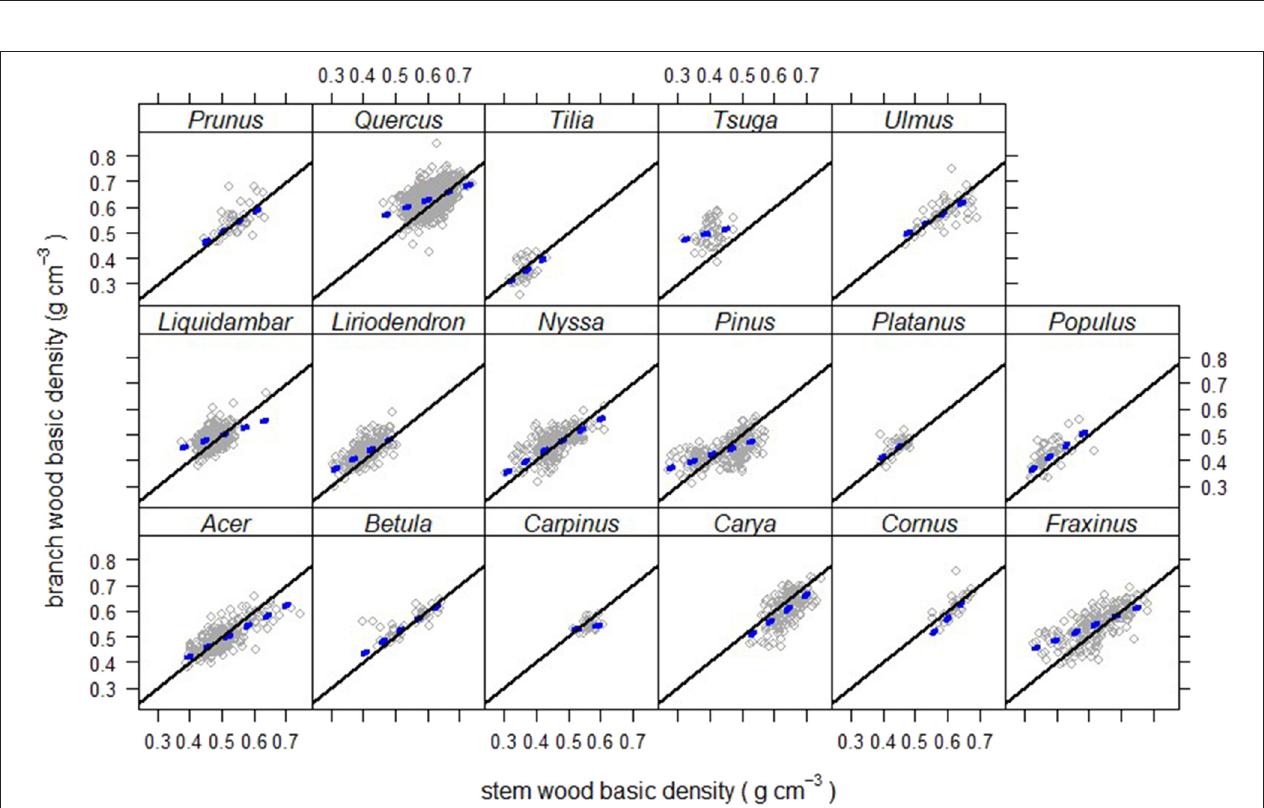
FIGURE 5 | Branch wood – stem wood basic density relationships for North American trees (gray circles) within different genera. Thick-dashed regression lines cover the domain of stem density for that species.